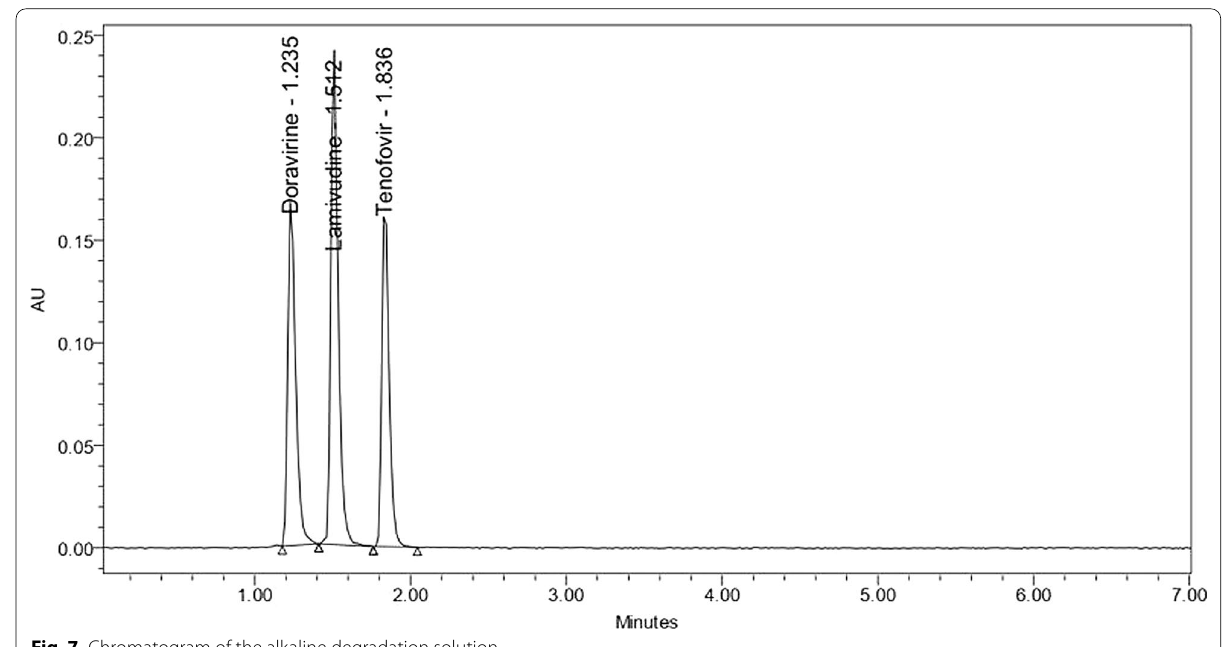
Fig. 7 Chromatogram of the alkaline degradation solution